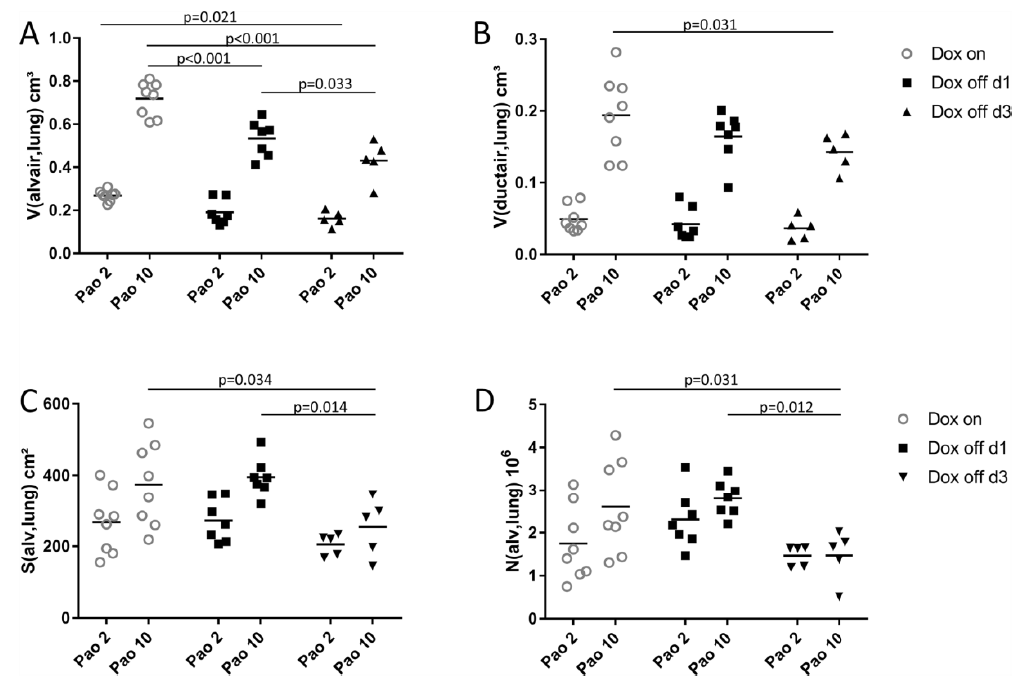
Figure 3. Acinar microarchitecture. The total volumes per lung of alveolar ( A ) V(alvair,lung) and ductal airspaces ( B ) V(ductair,lung) are given. In ( C ) the surface area of alveoli per lung S(alv,lung) and in ( D ) the total number of alveoli per lung N(alv,lung) are illustrated.